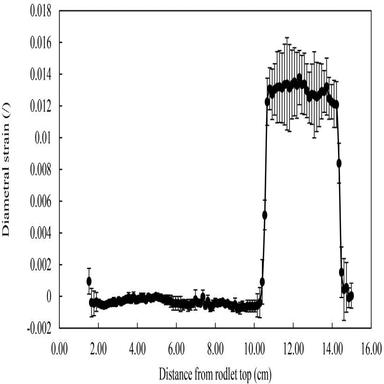
Axial profile of the cladding diametral strain of the rodlet.